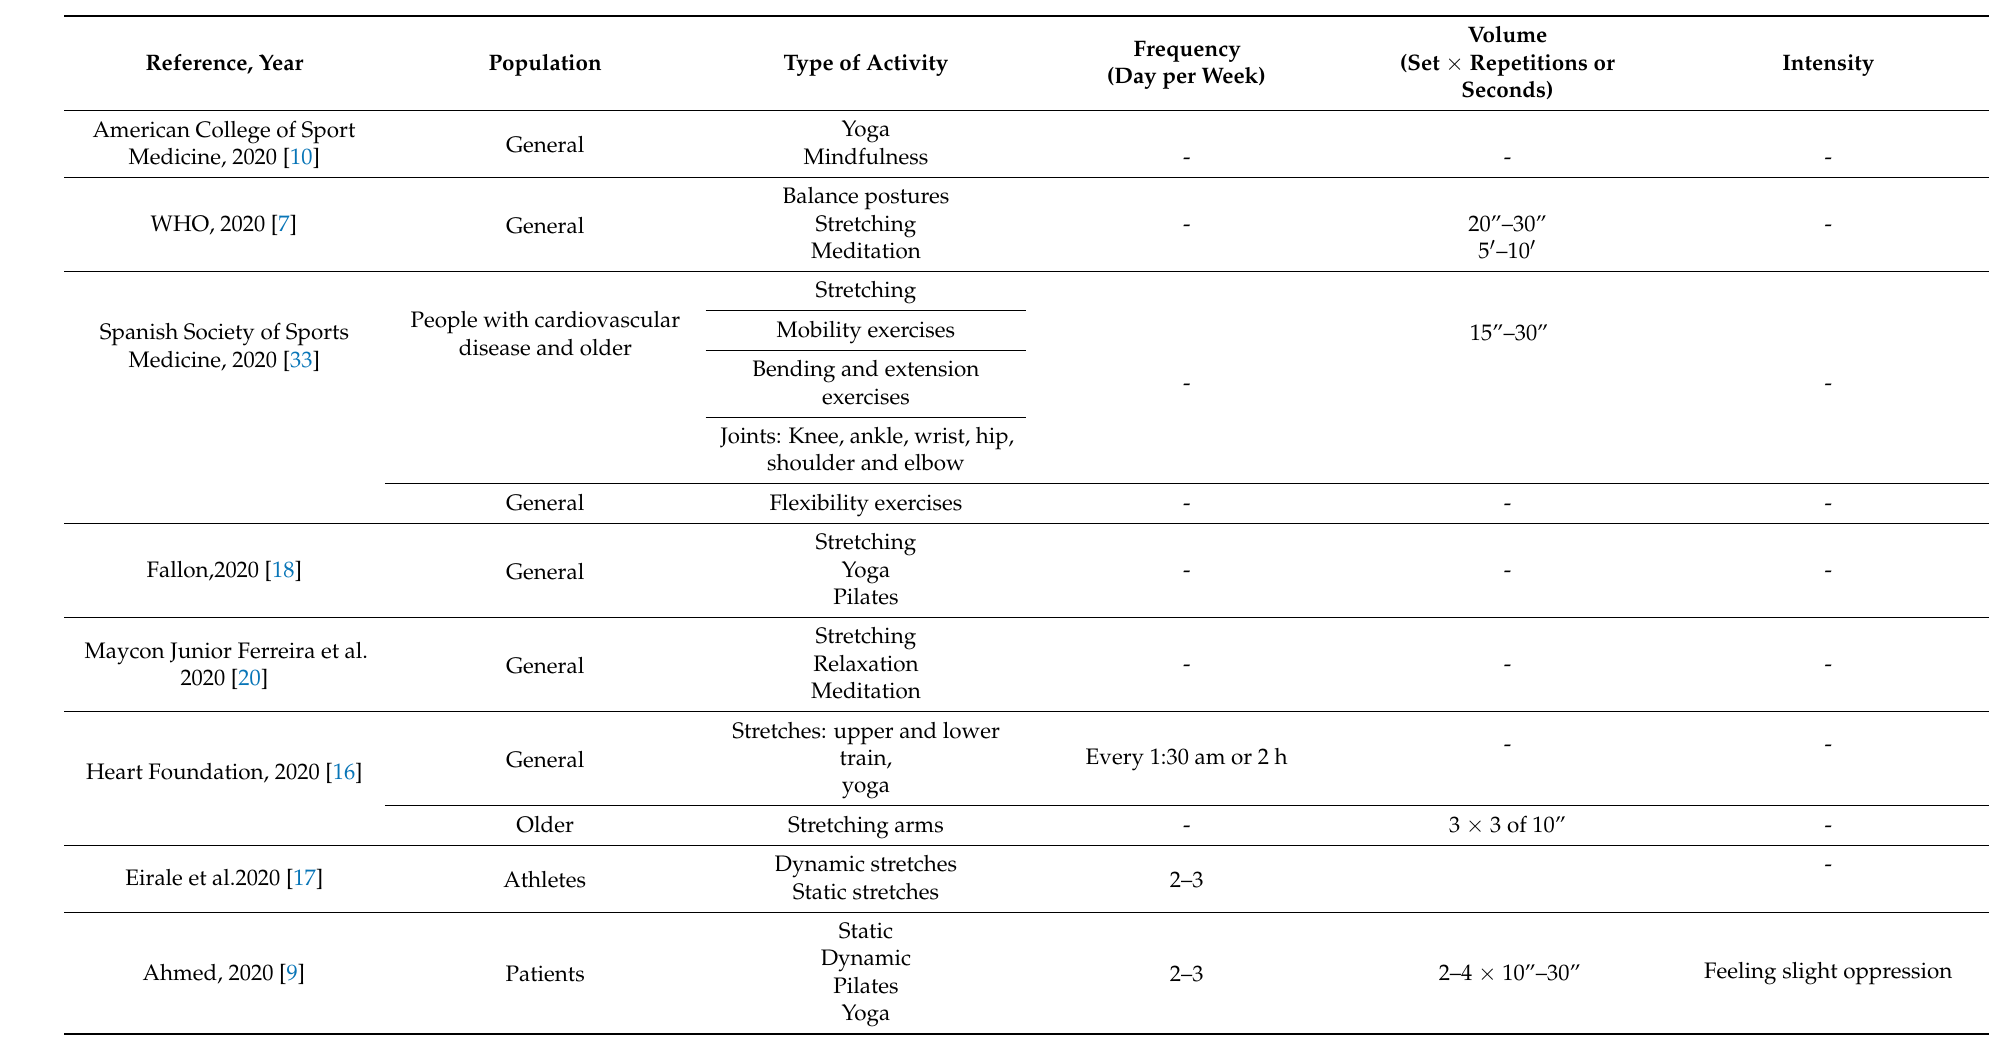
Table 3. Recommendations for flexibility-stretching,